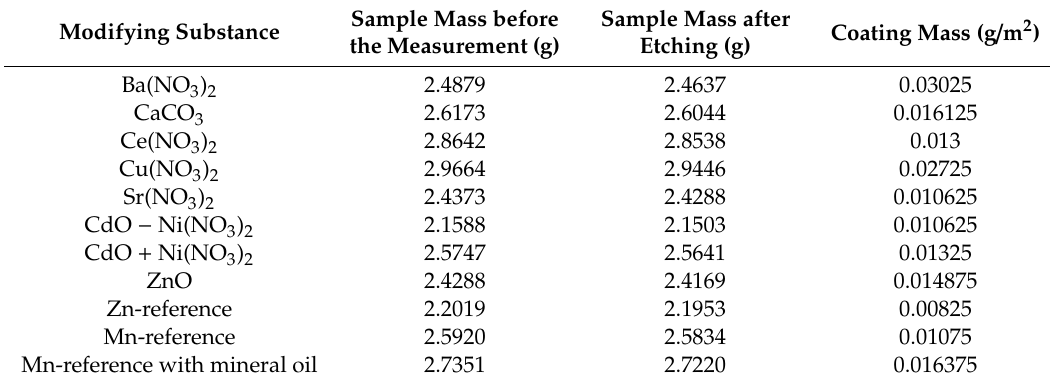
Table 8. Results of coating mass